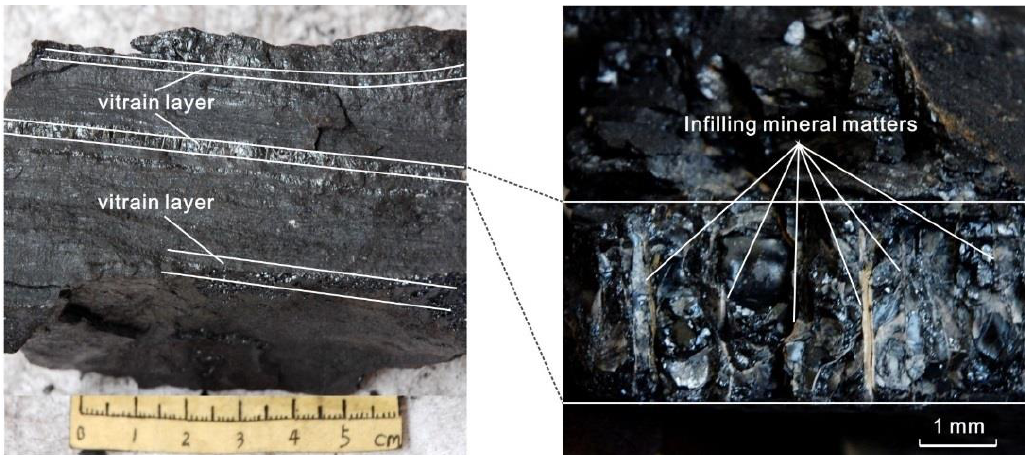
Figure 3. Photographs of coal structure (lateral section) with banded vitrain layers filled with mineral matter, No.3 coal from Songhe coalmine, Liupanshui coalfield of Southwestern China.